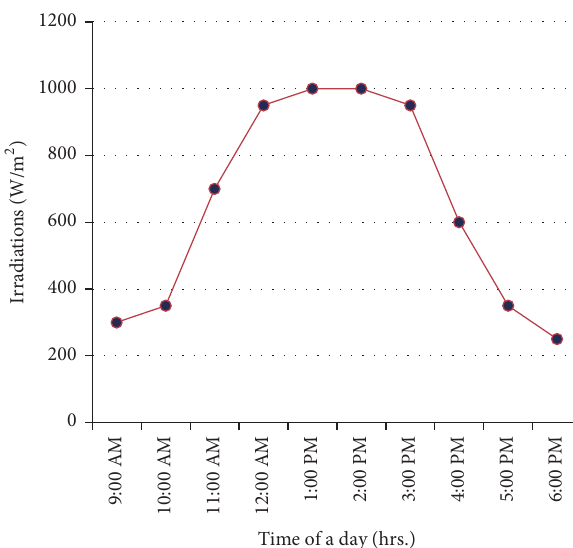
Time of a day (hrs.) Figure 7: Radiation variation of a Malaysian sunny day.